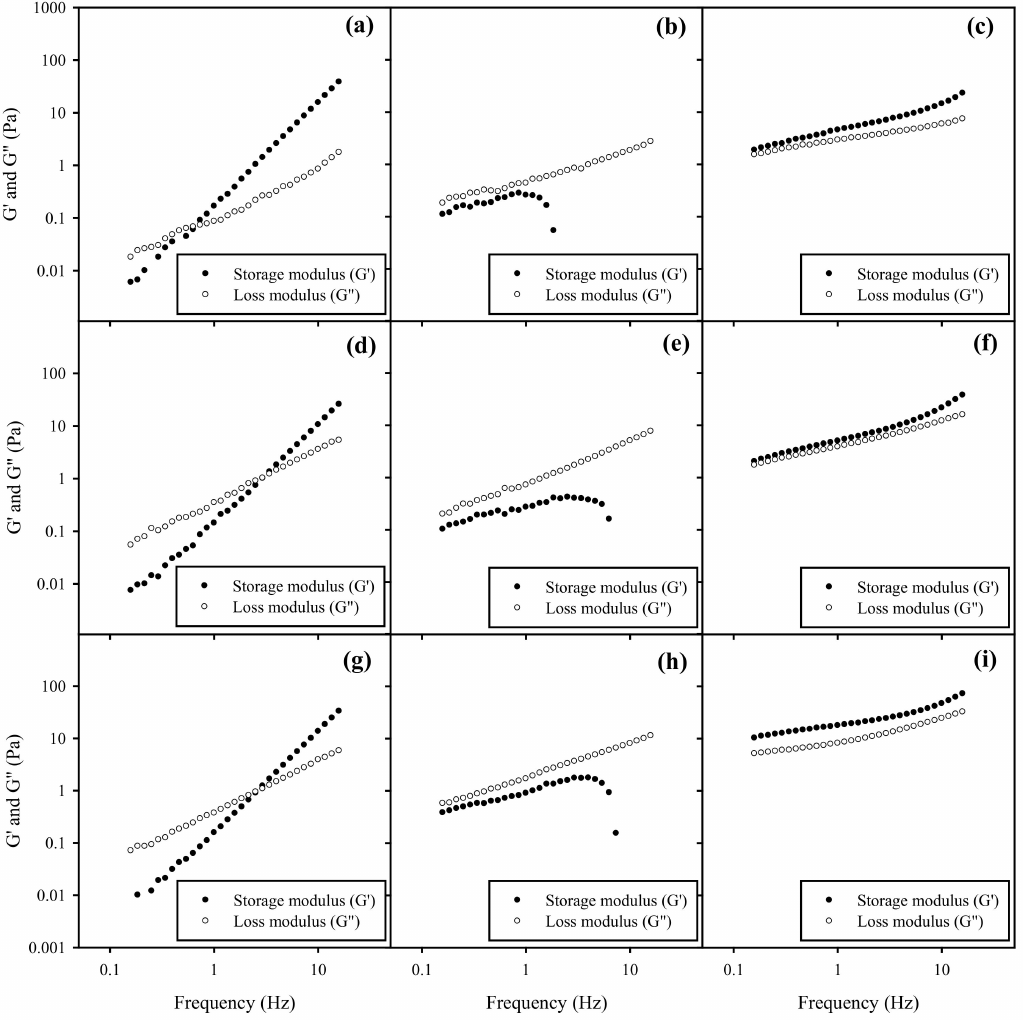
Figure 7. Frequency sweep on storage modulus • (G’) and loss modulus ratios for ( a ) 0/100, ( b ) 50/50, ( c ) 100/0 in the 3% HA gel. G’ and G” of AV oil NEs with SOR 30% and HL/TPGS ratios for ( d ) 0/100, ( e ) 50/50, and ( f ) 100/0 in the 6% HA gel. G’ and G” of AV oil NEs with SOR 60% for ( g ) 0/100, ( h ) 50/50, and ( i ) 100/0 in the 6% HA